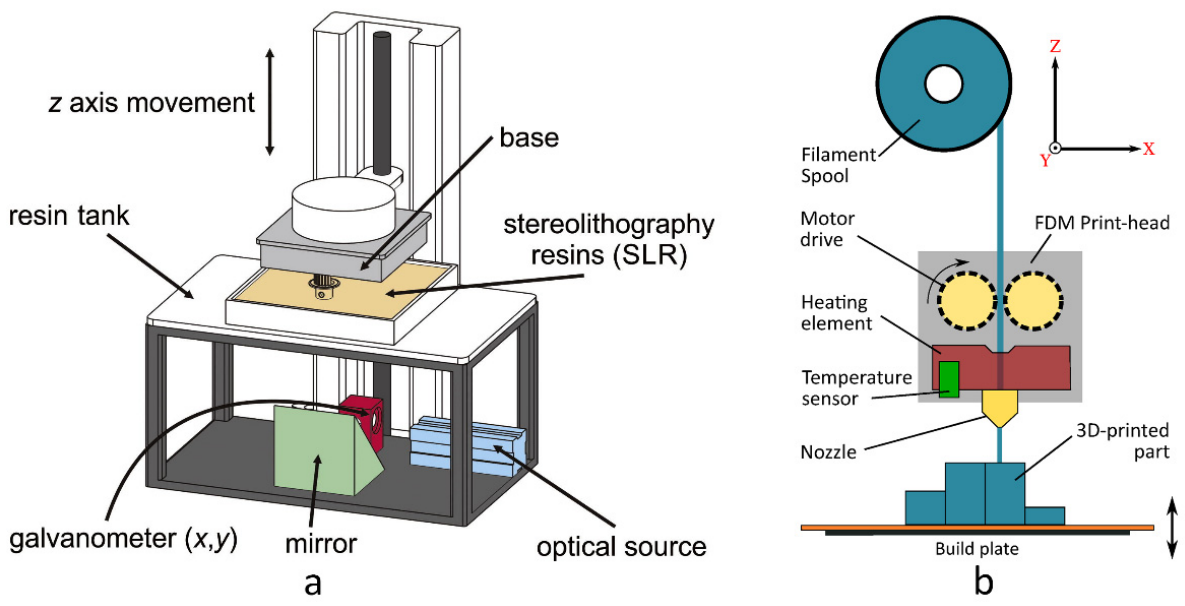
Figure 1. Schematics of ( a ) SLA reprinted with permission from Ref. [13]. Copyright 2016 Elsevier and ( b ) FDM [14] processes.